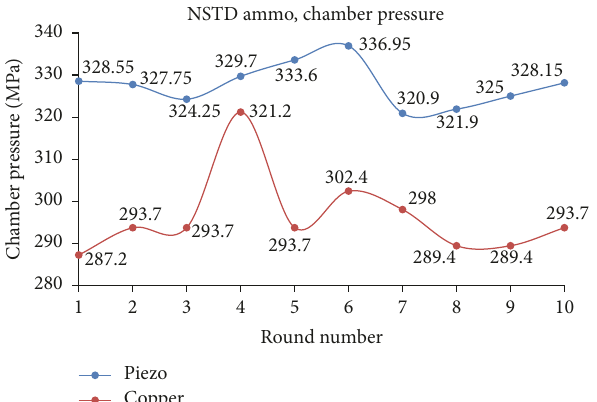
Figure 25: Comparison of chamber pressure measured with copper crusher and piezo sensor simultaneously using nonstandard ammu- nition.